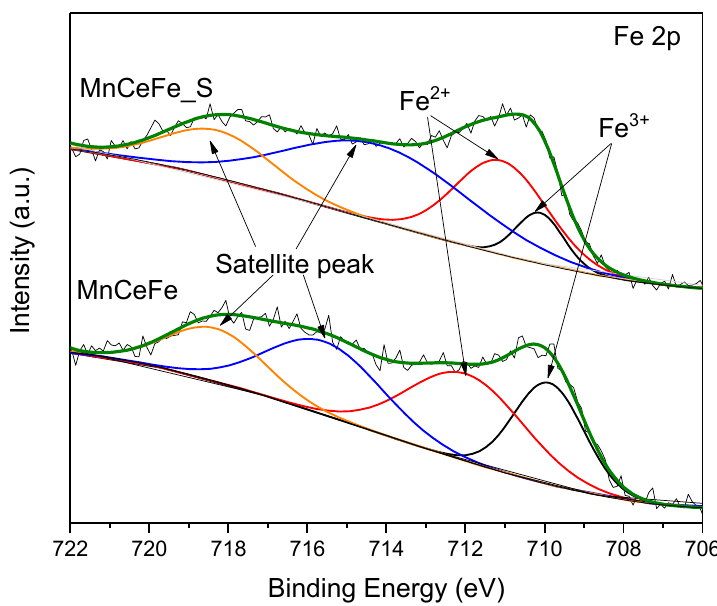
Figure 7. Fe 2p XP spectra of MnCeFe and MnCeFe_S. Table 8. Fe 2p XPS parameters of MnCeFe and MnCeFe_S.